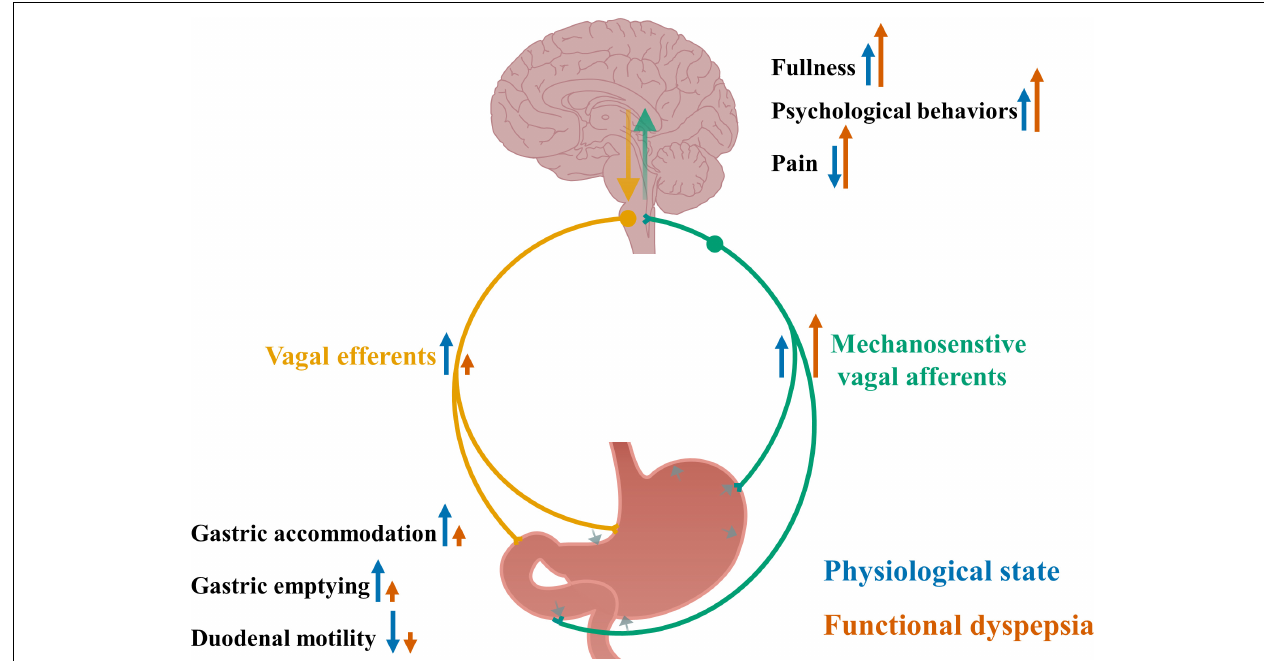
FIGURE 1 | Altered vagal signaling in response to gastric distension and its associated pathophysiological changes in functional dyspepsia. Gastric distension and contraction activate mechanosensitive vagal afferents and send signals to the brain, leading to increased feeling of fullness, increased psychological behaviors and reduced pain sensation, and further via vagal efferents send signals to the gut, leading to increased gastric accommodation and emptying, and reduced duodenal motility. In functional dyspepsia, the sensitivity of vagal afferents to gastric distension is increased, accompanying increased feeling of fullness, psychological behaviors and pain, and impaired gastric accommodation and emptying, and duodenal motility. Blue arrows indicate an effect to increase or decrease nerve activity or physiological outcomes under normal physiological conditions. Orange arrows indicate an effect to increase or decrease nerve activity or physiological outcomes in functional dyspepsia and the size of the arrows indicate the levels of the